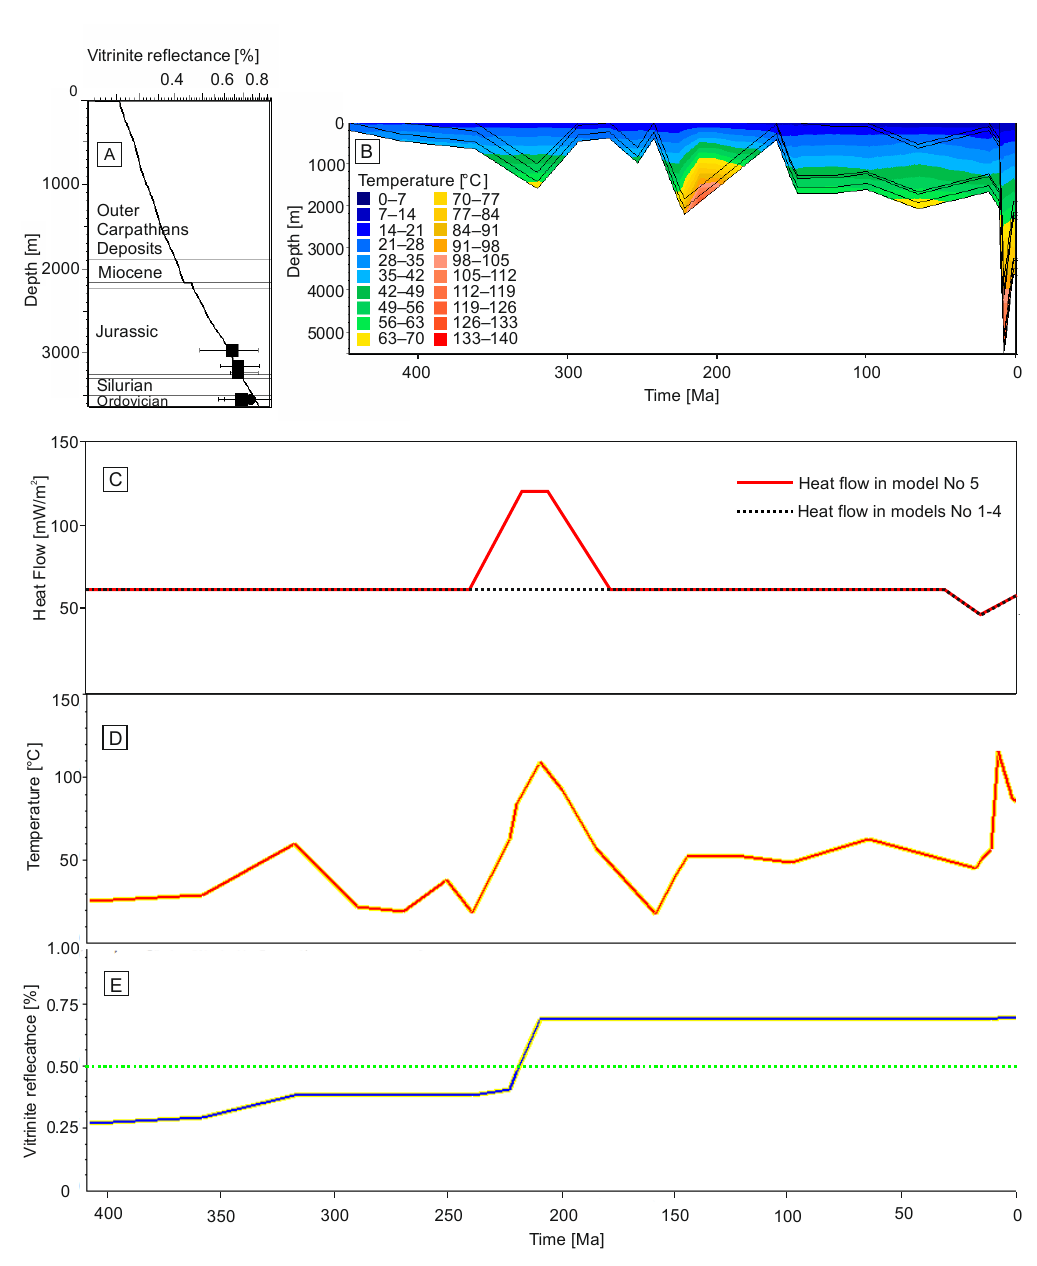
Figure 9. Results of maturity modelling for the Pilzno-40 well assuming that 1500 m of Triassic rocks were removed in the study area and heat flow was elevated to 120 mW/m 2 during the Latest Triassic. ( A ) Calibration of the model by comparison of measured VR values and calculated VR curve; ( B ) burial history curves with temperature overlay; ( C ) heat flow evolution; ( D ) temperature for top of Silurian strata in the Pilzno-40 well. Note that the maximum temperature of ca. 110 ◦ C occurred in the Earliest Jurassic and also during the Carpathian overthusting in the Miocene. ( E ) Vitrinite reflectance evolution for Silurian strata applying model no. 5. The green dash line is the VR value equals 0.5% that represents border between immature and mature kerogen. A significant increase in VR developed in Late Triassic to Early Jurassic. Therefore, hydrocarbon generation developed in that period. No particular VR overprint occurred in the Miocene. Such model diagenesis is supported by an illite K-Ar age of ca. 200 Ma from Silurian bentonite in the ˙ Zukowice-39 well